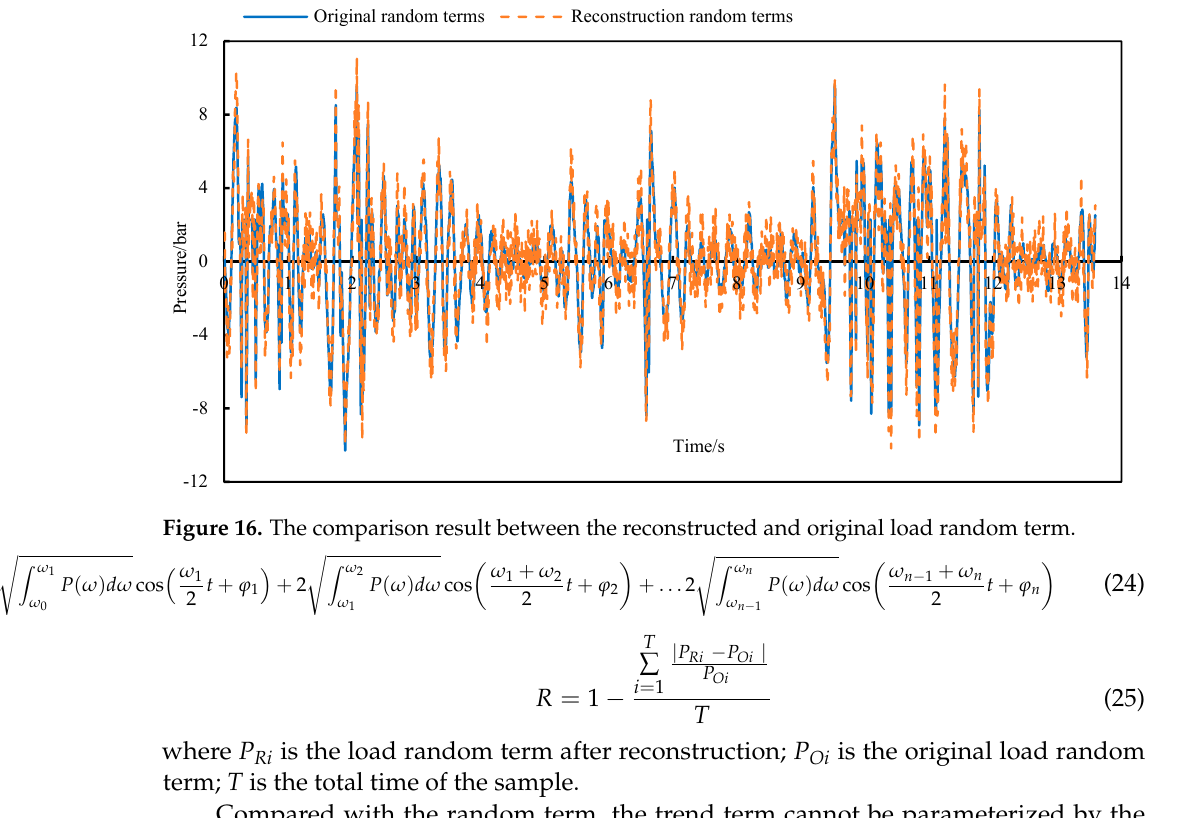
Figure 15. Power spectral density of load random term.